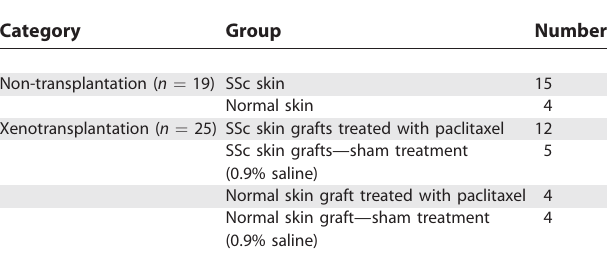
Table 1. The Summary of Skin Samples Used in the Study Category